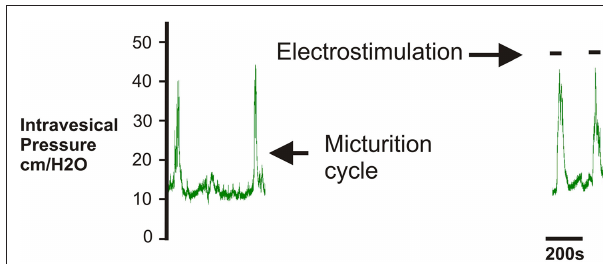
Figure 5 | At the conclusion of the experiment neurostimulation was applied to the postganglionic bladder nerve to confirm the viability of the nerve and specificity of the recording. Square-wave pulses (0.3 ms, 12 Hz, 2 V) were delivered by a Grass stimulator, resulting in detrusor contraction with a rise in the intravesical